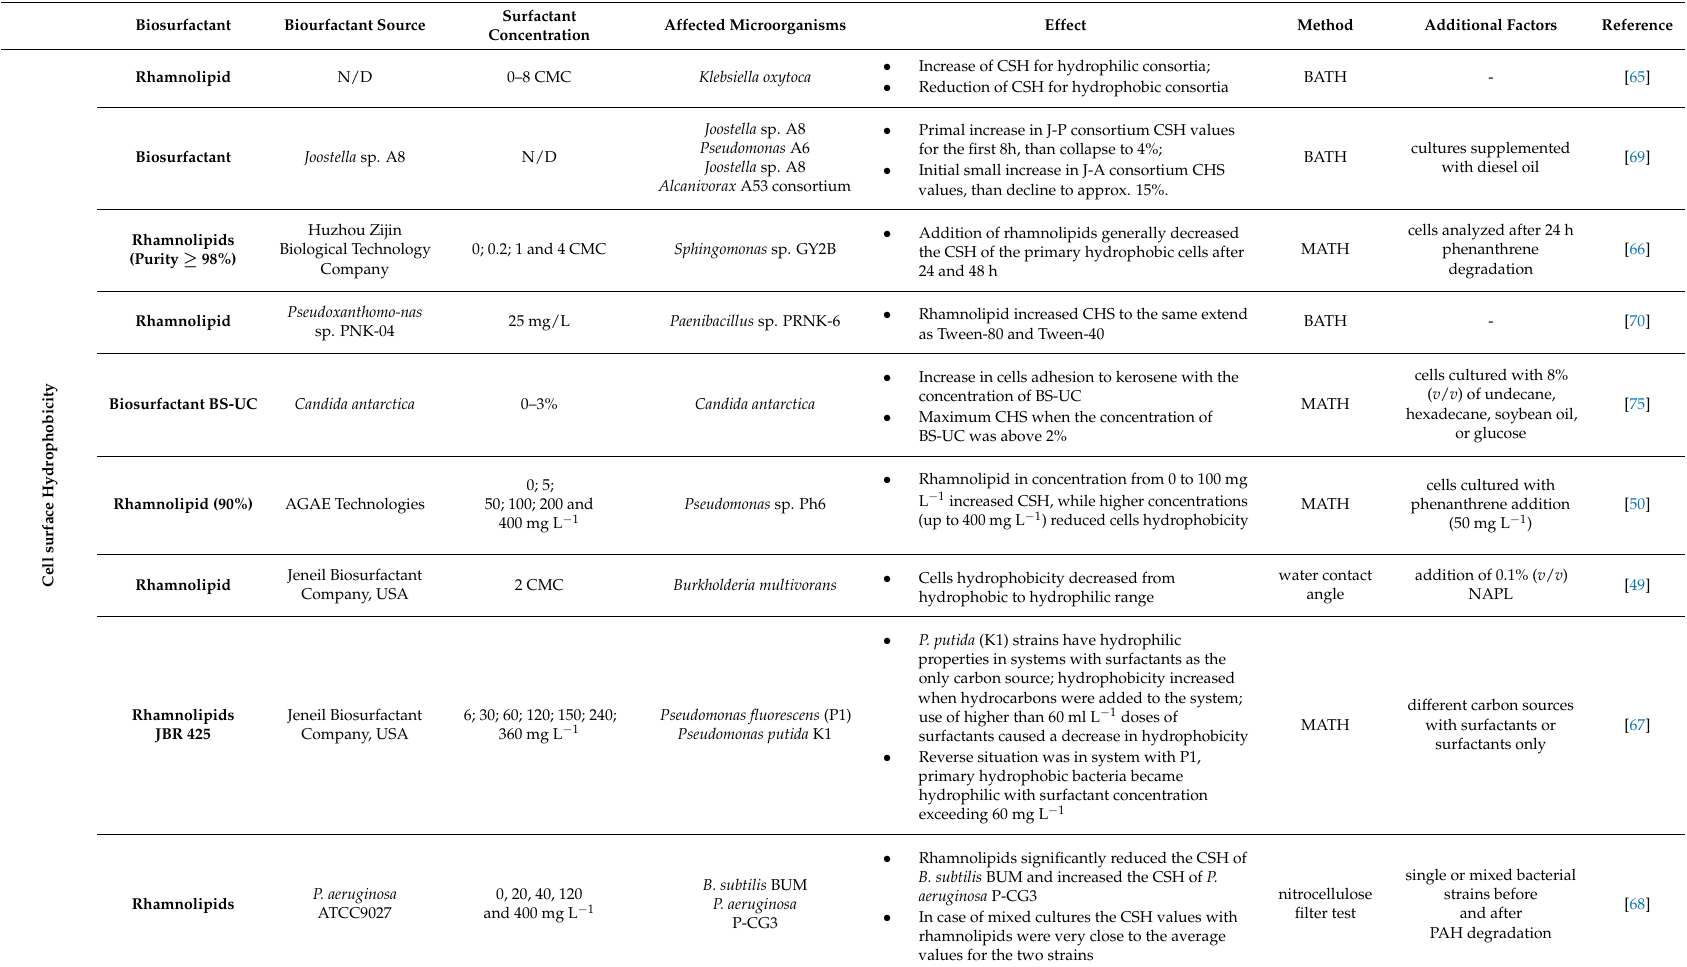
Table 2. Cell surface parameters affected by biosurfactants addition and effects of this